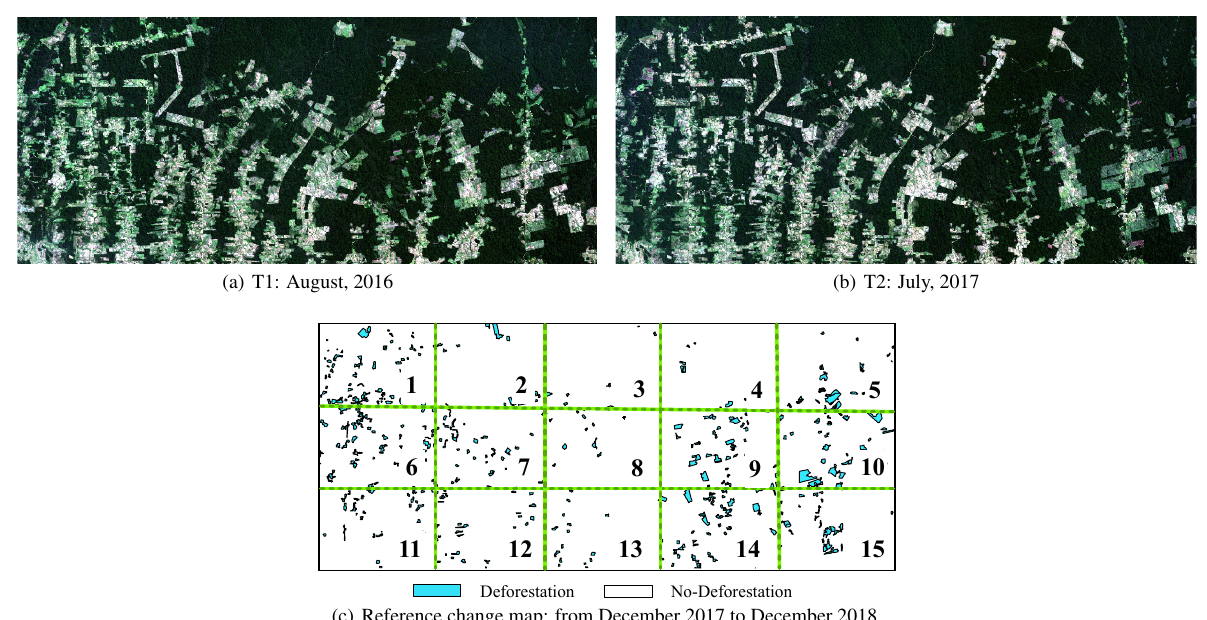
Figure 3. RGB composition of the selected Amazon Forest region at dates T1 (a) and T2 (b); and the deforestation reference set (c). The study area is divided into 15